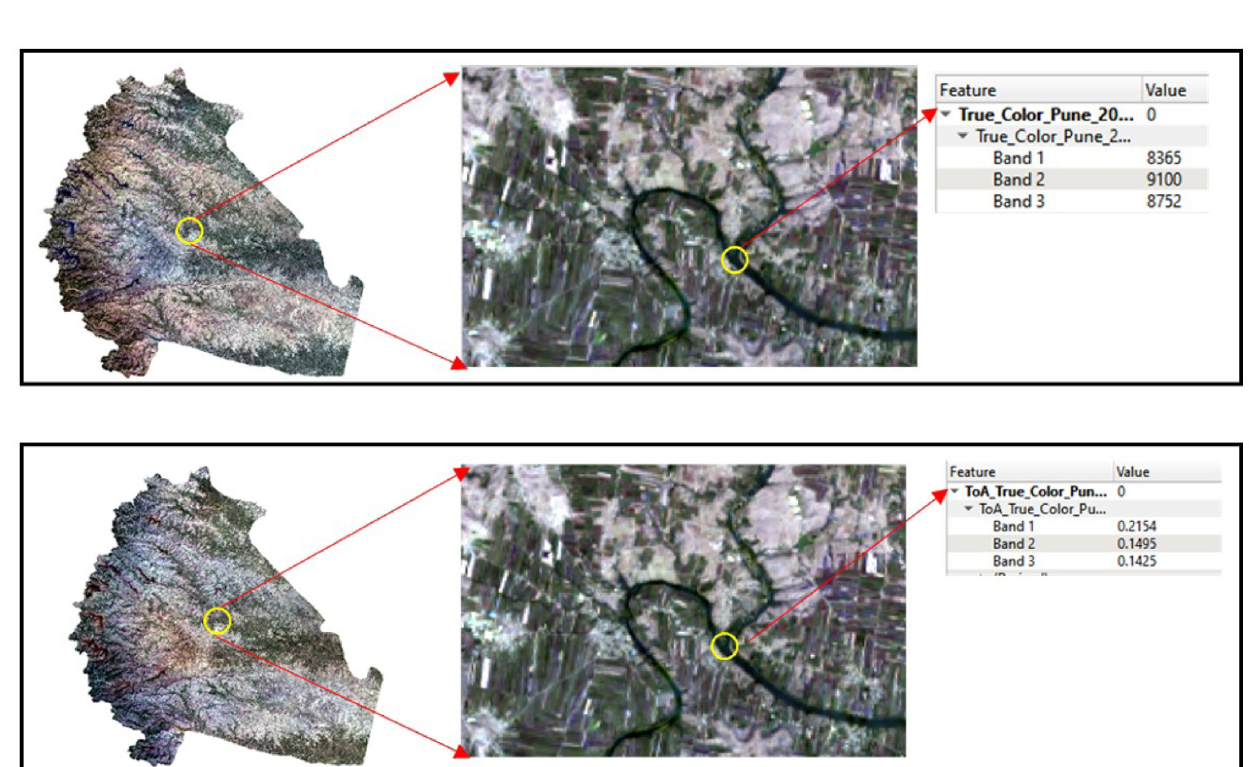
Figure 3. Raw Landsat 8 image of 6th February 2016 representing conversion of Digital Numbers (DN) to Top of Atmosphere (ToA) Reflectance. Landsat 8 images courtesy of the U.S. Geological